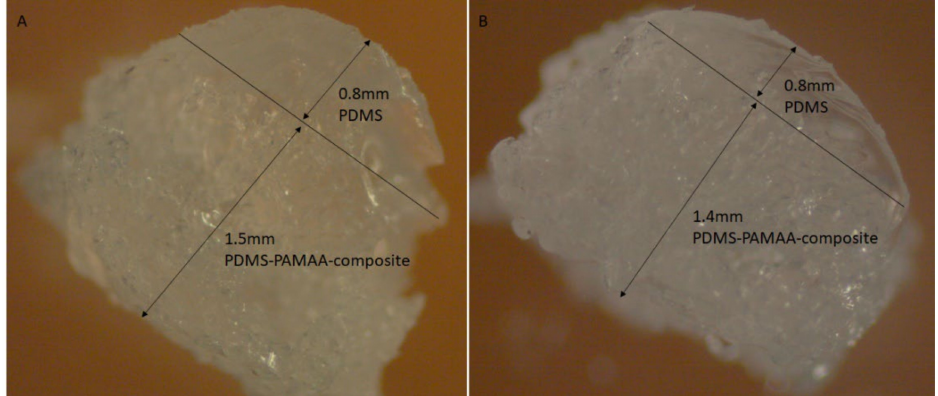
Figure 9. Cross-sections of design B samples with ( A ) initial hydrogel content of 20 wt% and a hydrogel particle size of 48 µ m, and ( B ) initial hydrogel content of 30 wt% and a hydrogel particle size of 77 µ